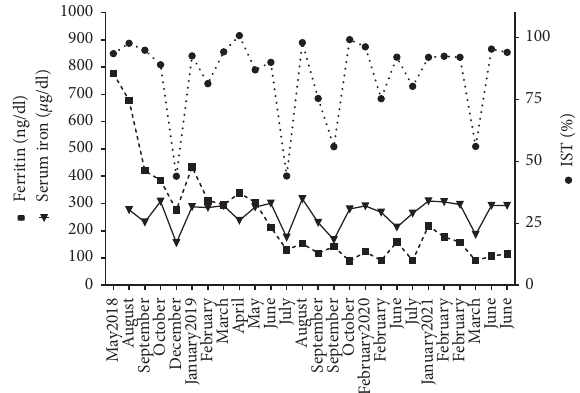
Figure 2: Serum ferritin and iron (left ordinate axis) and index saturation transferrin (right ordinate axis) of patient during phlebotomies